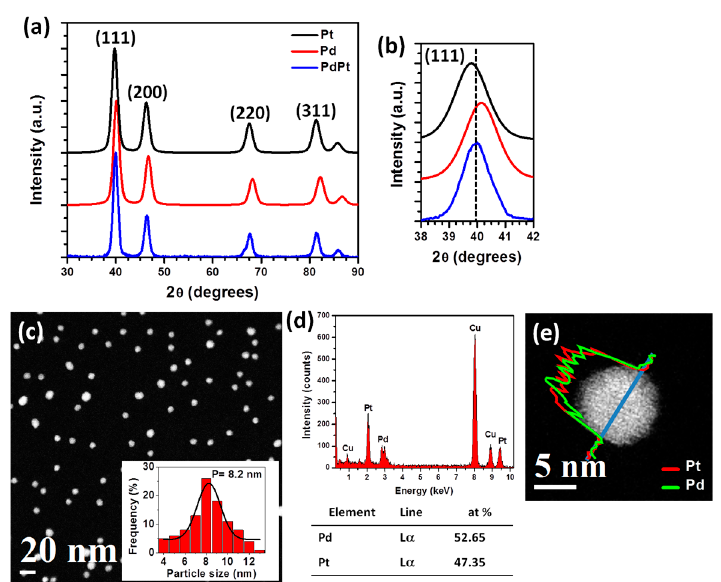
Figure 1. ( a ) X-ray diffraction (XRD) patterns of Pt, Pd and PdPt nanoparticles, ( b ) magnified zone of the (111) reflection, ( c ) low magnification high-angle annular dark-field scanning transmission electron microscopy (HAADF-STEM) image, ( d ) Energy-dispersive X-ray spectroscopy (EDS) spectrum of the bimetallic nanoparticles and ( e ) EDS line scan profile of a single bimetallic nanoparticle.